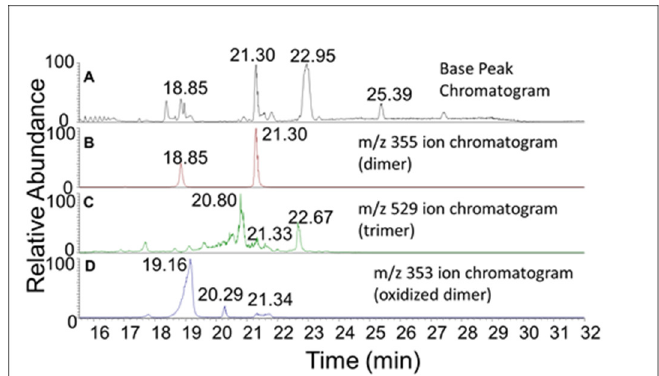
Figure 5. The base Peak and ion chromatograms of DBL catechol reaction products. The RP-HPLC / ESI-MS/MS base peak chromatogram produced during the incubation of DBL catechol with tyrosinase. ( A ) shows the base peak chromatogram. The ion chromatograms of dimeric, trimeric, and oxidized forms of the dimeric species are presented in ( B – D ) respectively.